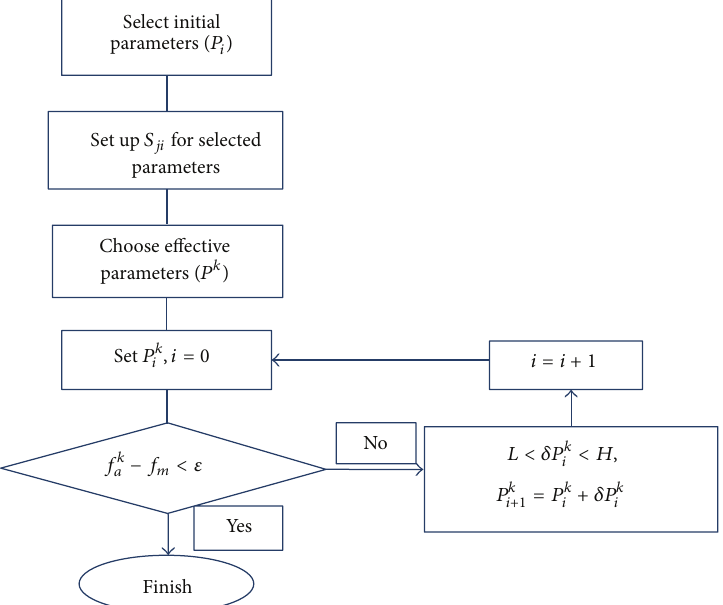
Figure 1: FE model tuning algorithm.